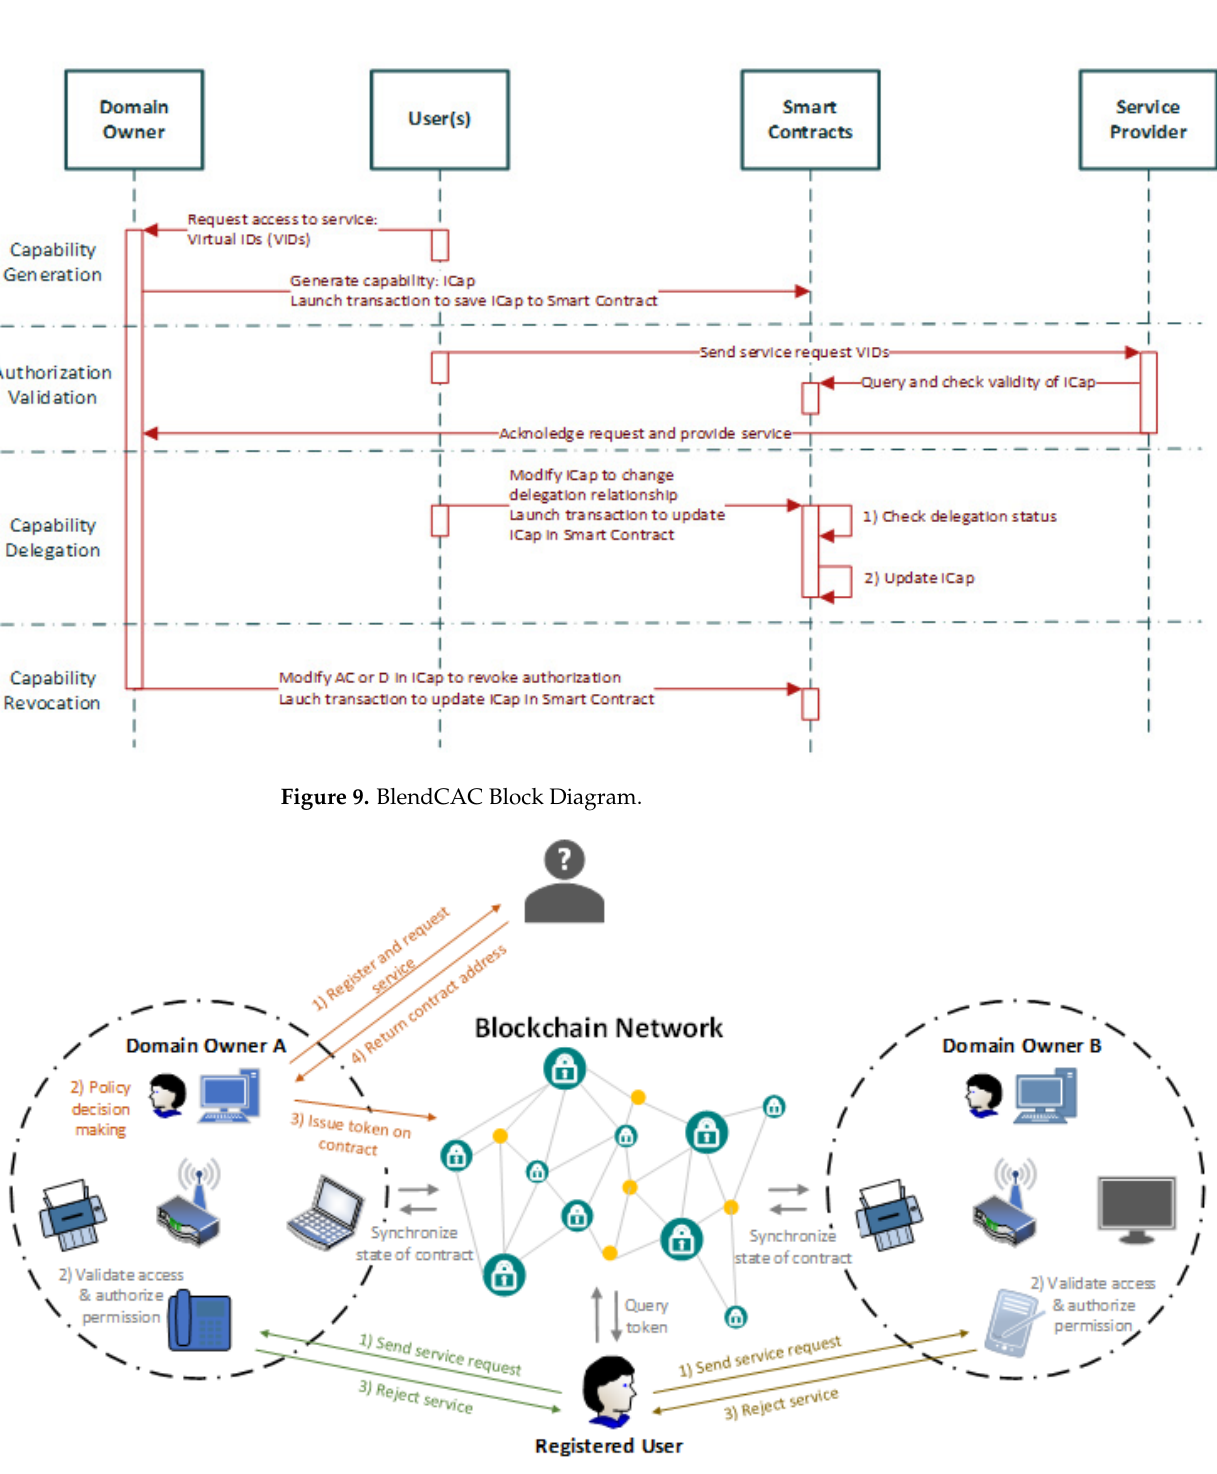
Figure 9. BlendCAC Block Diagram.